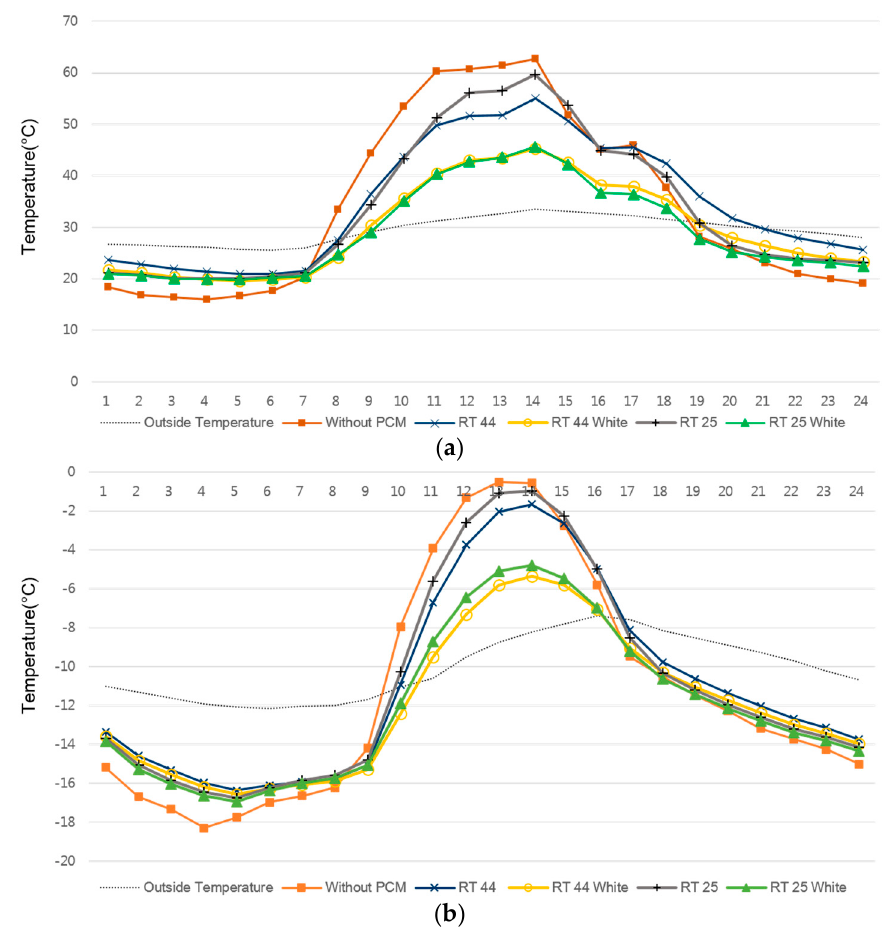
Figure 14. Roof surface temperature. ( a ) A typical summer day; ( b ) A typical winter day.